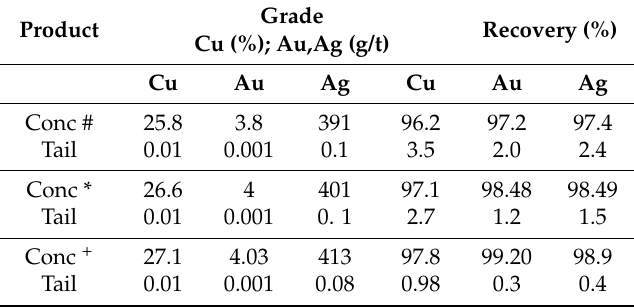
Table 4. Grade and Recovery in presence of a mixture of SIBX and BBT (1:1) at total collector concentration 3 × 10 − 5 M and natural pH with respect to the sequence of the collector addition. Grade Product Cu (%); Au,Ag